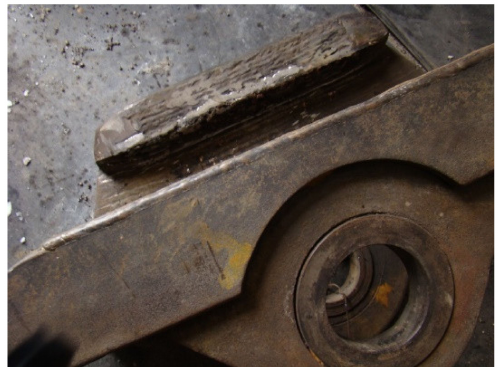
Figure 14. Reconditioned captive guiding.